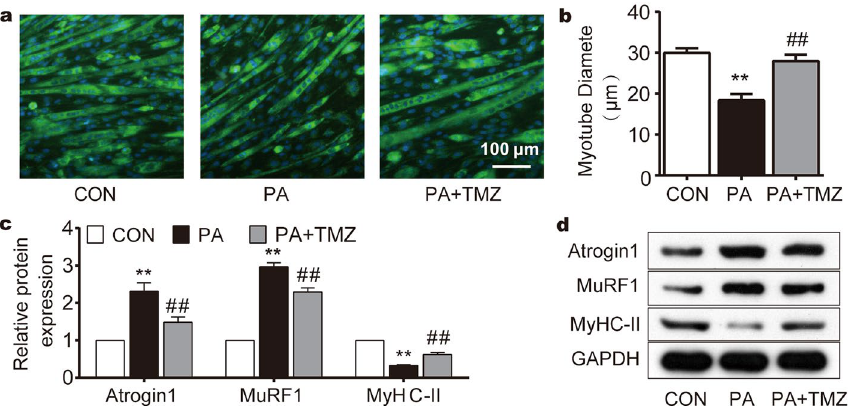
Figure 1. TMZ prevents palmitate (PA)-induced muscle cell damage. Con control group without palmitate treatment, PA skeletal muscle cells treated with palmitate, TMZ skeletal muscle cells treated with trimetazidine. ( a , b ) MyHC-II immunofluorescence staining was performed to observe the myotube cell morphology and myotube diameter with a 100 μm scale. ( c , d ) MyHC-II, MuRF1, and Atrogin1 protein expression were detected by Western blot. *, ** represented p < 0.05, p < 0.01 in comparison with the Con group, respectively. # , ## represented p < 0.05, p < 0.01 in comparison with the PA group,